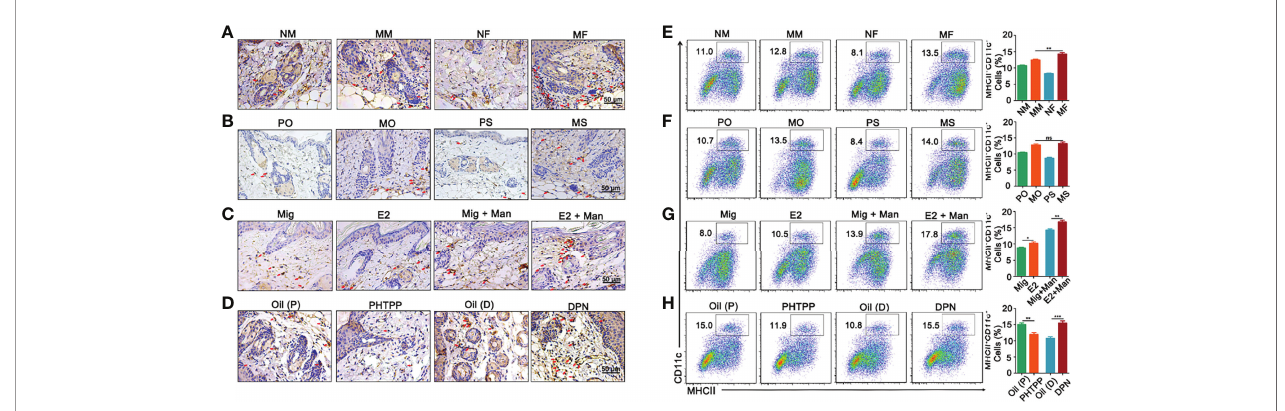
FIGURE 4 | Dendritic cells from dermis and spleen contributed to estrogen promoted psoriasis. (A) Immunohistochemistry staining of CD11c + cells in dermis (arrows mark representative cells) from female and male mice without or with mannan application (n = 5/group). Effect of (B) endogenous estrogen, (C) 17- b - estradiol, (D) PHTPP and DPN on CD11c + cells in the dermis under normal or in fl ammatory conditions (n = 5/group). Scale bar: 50 µm. (E) Presence of MHCII + CD11c + cells in the spleen from female and male mice (n = 5/group). Effect of (F) endogenous estrogen, (G) 17- b -estradiol, (H) ER- b antagonist or agonist on MHCII + CD11c + cells (n = 5/group). Each experiment was repeated twice. Man, mannan; NM, Naive Male; MM, Man + Male; NF, Naive Female; MF, Man + Female; PO, PBS + OVX; MO, Man + OVX; PS, PBS + Sham; MS, Man + Sham; Mig, miglyol; E2, 17- b -estradiol; Oil (P), E2 + Corn oil + Man; PHTPP, E2 + PHTPP +Man; Oil (D), Corn oil + Man; DPN, DPN + Man. Statistical analyses were performed using an unpaired t test and n indicates number of mice used in each group. The data represent mean ± SEM. ns, not signi fi cant. *p < 0.05; **p < 0.01. ***p <